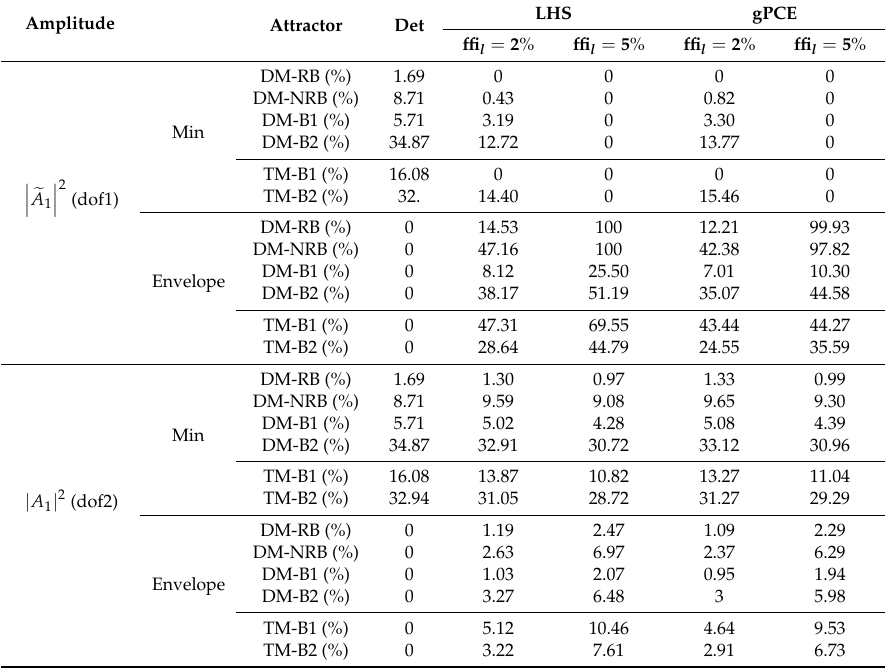
Table 5. Comparison of the contributions of different attractors in the basins of attraction computed using the LHS and gPCE methods, for deterministic case, δ l = 2% and δ l = 5%. Amplitude Attractor Det